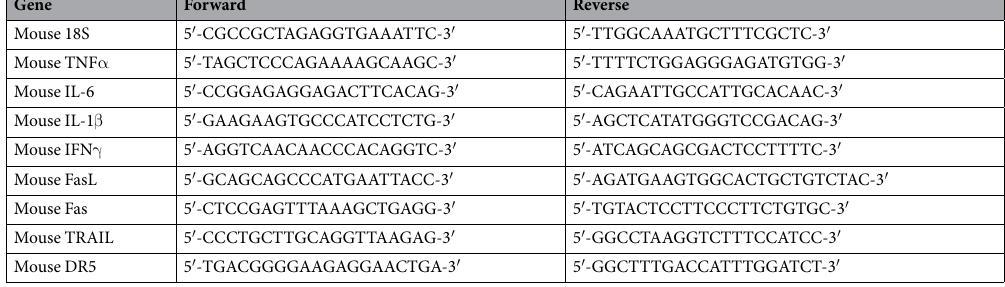
Table 1. Primer sequences used for